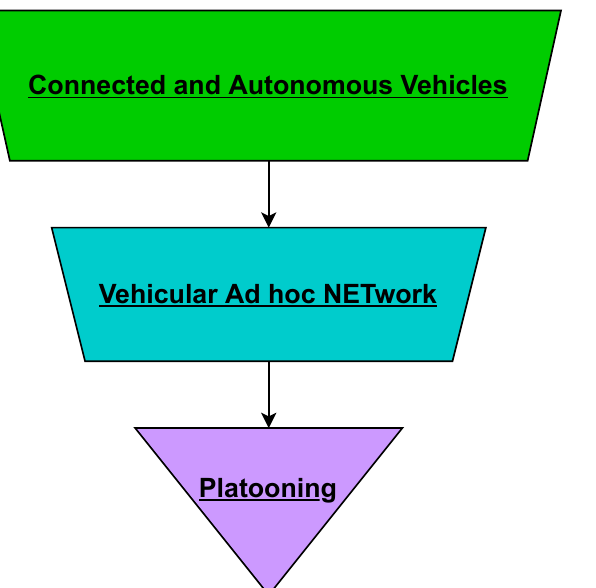
Figure 1. A visual representation of relationship between CAV, VANET, and Vehicular